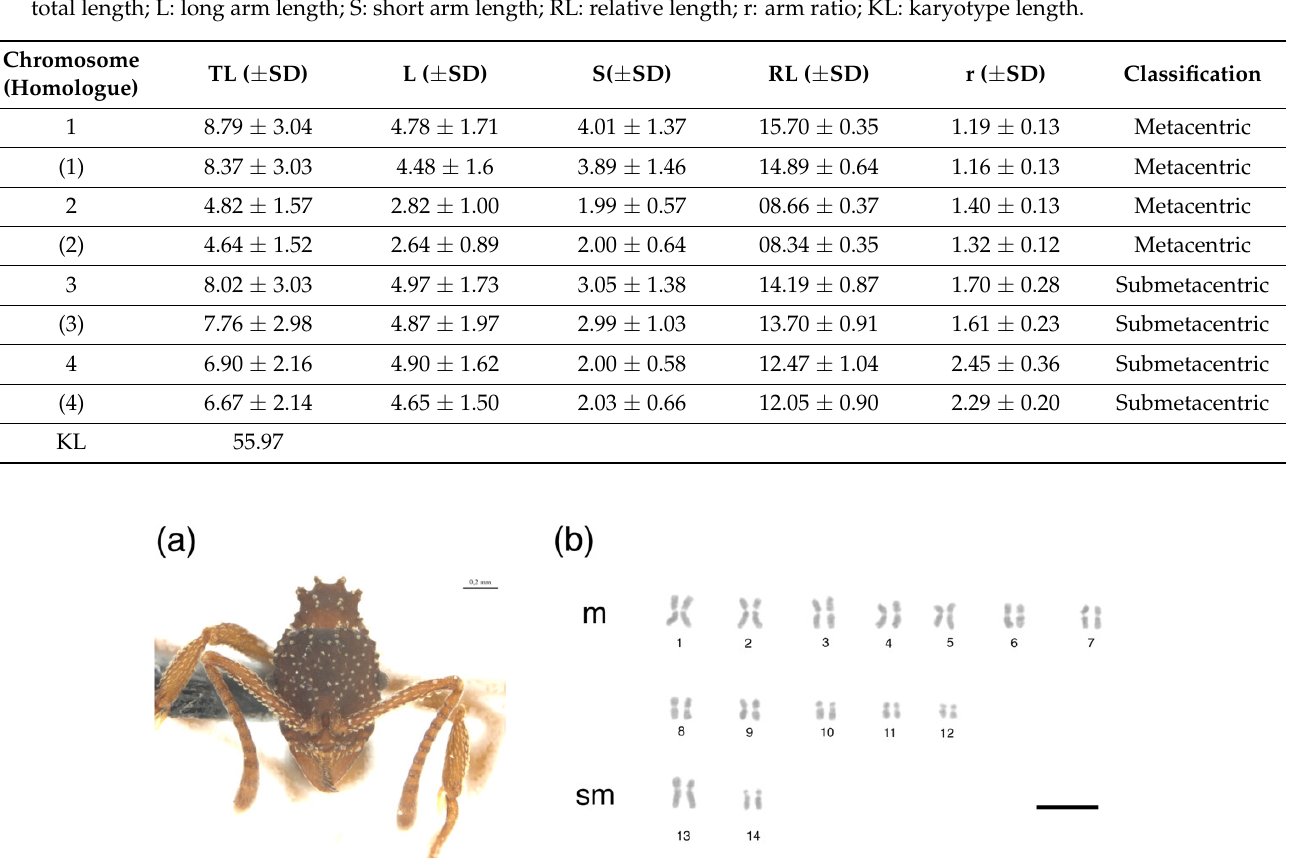
Figure 2. Mitotic chromosomes of Myrmicocripta sp. stained with Giemsa. Species ( a ) images and ( b ) diploid karyotype of Myrmicocripta sp. with 2 n = 28 chromosomes. m = metacentric; sm = submetacentric. Scale bar = 5 µm. Ant image was obtained in our lab. Table 2. Karyomorphometric analyses of the chromosomes of Myrmicocripta sp. All measurements are given in “µm”. TL: total length; L: long arm length; S: short arm length; RL: relative length; r: arm ratio; KL: karyotype length.